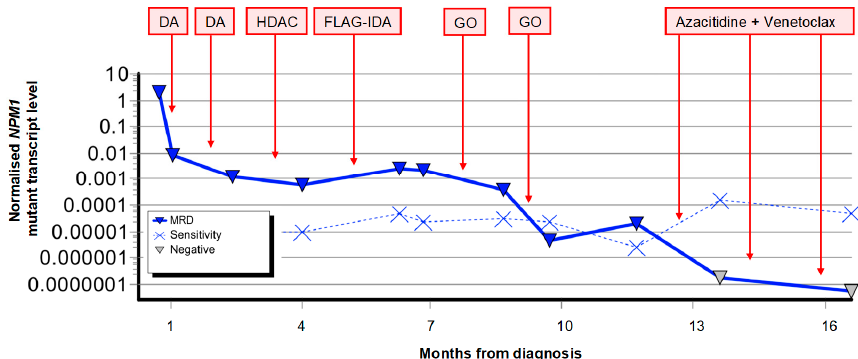
Figure 2. Example of MRD-guided therapy to achieve durable molecular complete remission in a 72-year old male ineligible for stem cell transplantation due to renal impairment [58]. DA: daunorubicin and cytarabine. HDAC: high dose cytarabine. FLAG-IDA: fludarabine, cytarabine, granulocyte colony stimulating factor and idarubicin. GO: gemtuzumab ozogamycin.